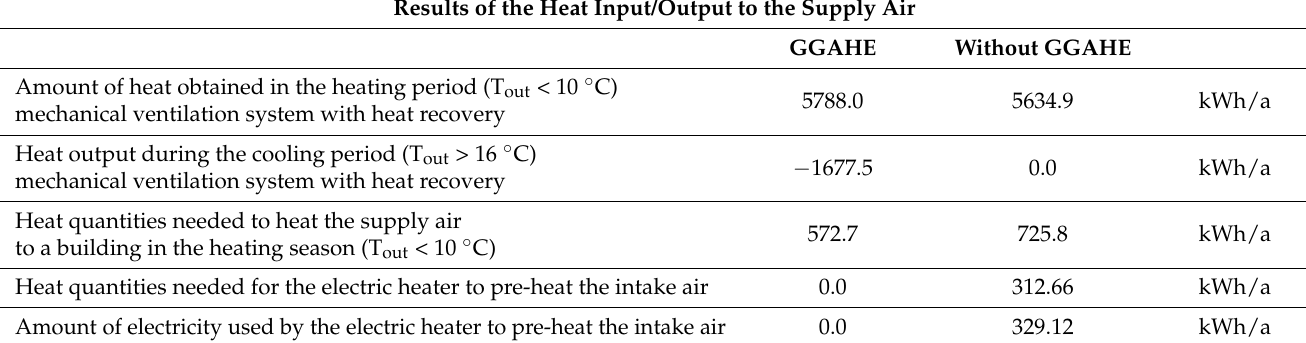
Table 2. The amount of heat supplied/exhausted into the supply air of the building.